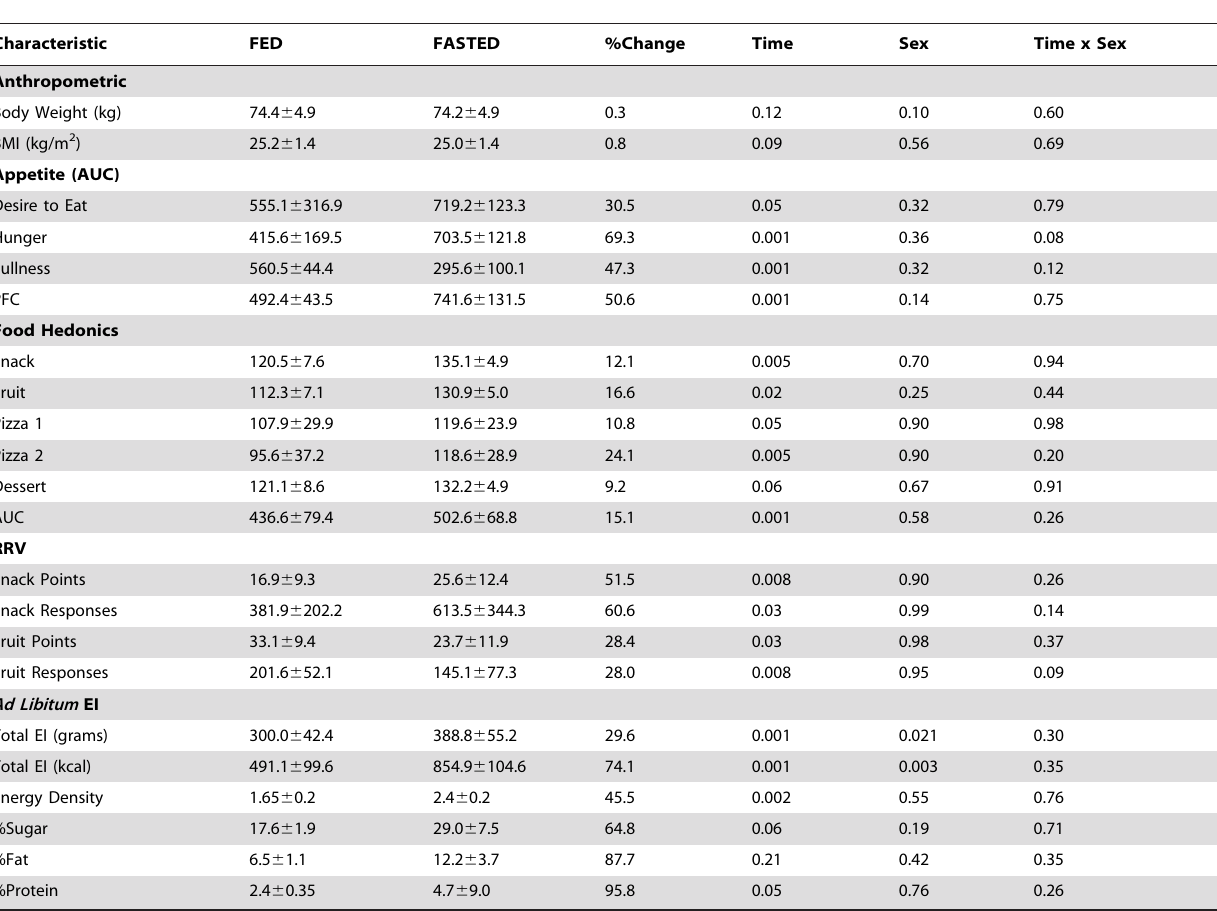
Table 1. Subjects’ characteristics under FED (control) and FASTED (experimental)